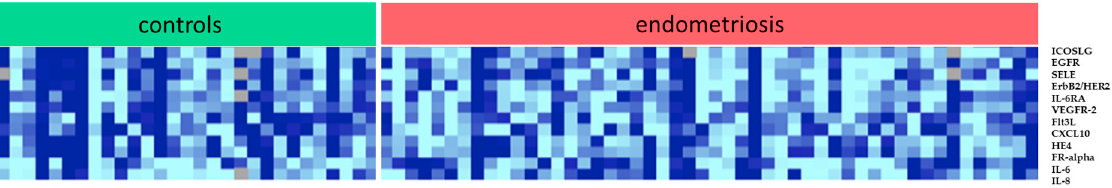
( p = 0.022), Epidermal growth factor receptor (EGFR) ( p = 0.023), Vascular endothelial growth factor receptor 2 (VEGFR-2) ( p = 0.026), ICOS ligand (ICOSLG) ( p = 0.027), Epididymal secretory protein E4 (HE4) ( p = 0.029), C-X-C motif chemokine 10 (CXCL10) ( p = 0.032), Receptor tyrosine-protein kinase erbB-2 (ErbB2 / HER2) ( p = 0.032), E-selectin (SELE) ( p = 0.037) and Folate receptor alpha (FR-alpha) ( p = 0.049) were underexpressed in women with endometriosis. Interleukin-6 (IL-6) and Interleukin-8 (IL-8) however were overexpressed 2.13-fold and 2.56-fold respectively ( p = 0.045